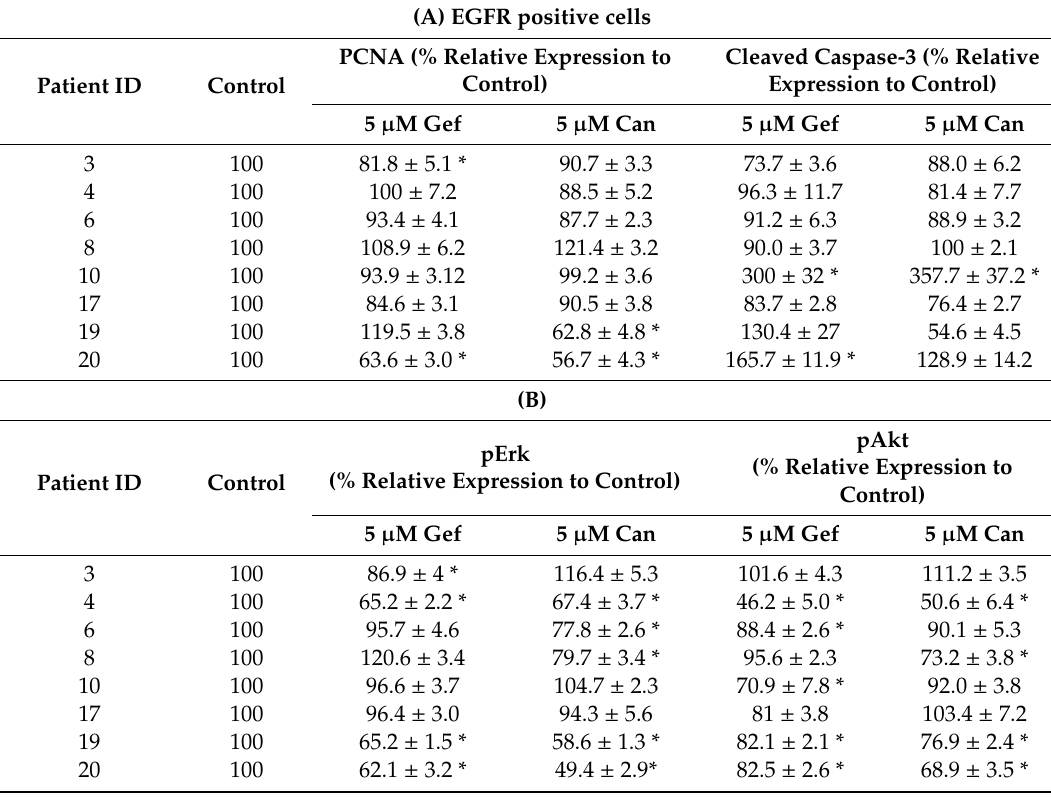
Table 5. The protein level of PCNA, cleaved caspase-3, pERK (Tyr 204) and pAKT (Ser 473) in EGFR positive cells are a ff ected by gefitinib (Gef) and canertinib (Can). The changes of PCNA and cleaved caspase-3 in Gef and Can treated cells are not prominent ( A ). The decrease in pERK (Tyr 204) and pAKT (Ser 473) is random in some selected patient cells ( B ). The fluorescent intensity of control is normalised to 100% and the fluorescent intensity of treatment is calculated relatively to the control sample. Representative analysis was from a set of two independent experiments and each experiment had at least three duplicates. Mean ± SE; n = 2 is presented and statistical significance was determined by a t -test ( * , p <